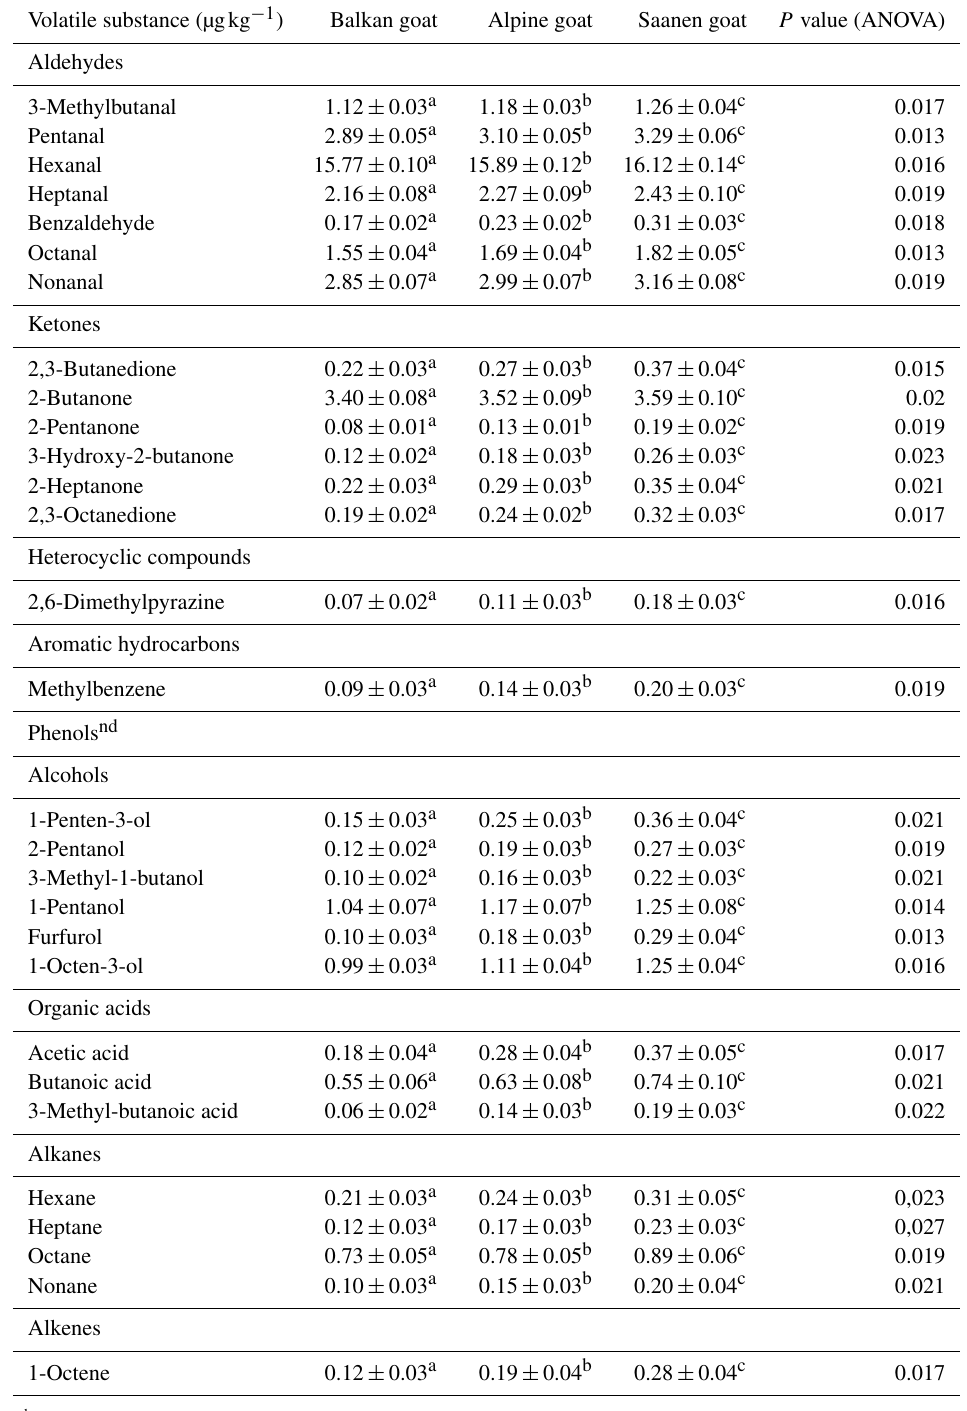
Table 4. Volatile substances in fresh m. gluteus superficialis meat (µgkg − 1 ) according to goat breed ( n = 40 per